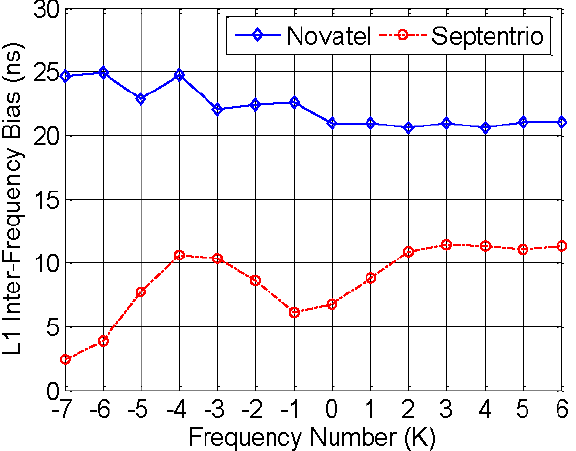
Figure 7. Inter-frequency bias of GLONASS L1.